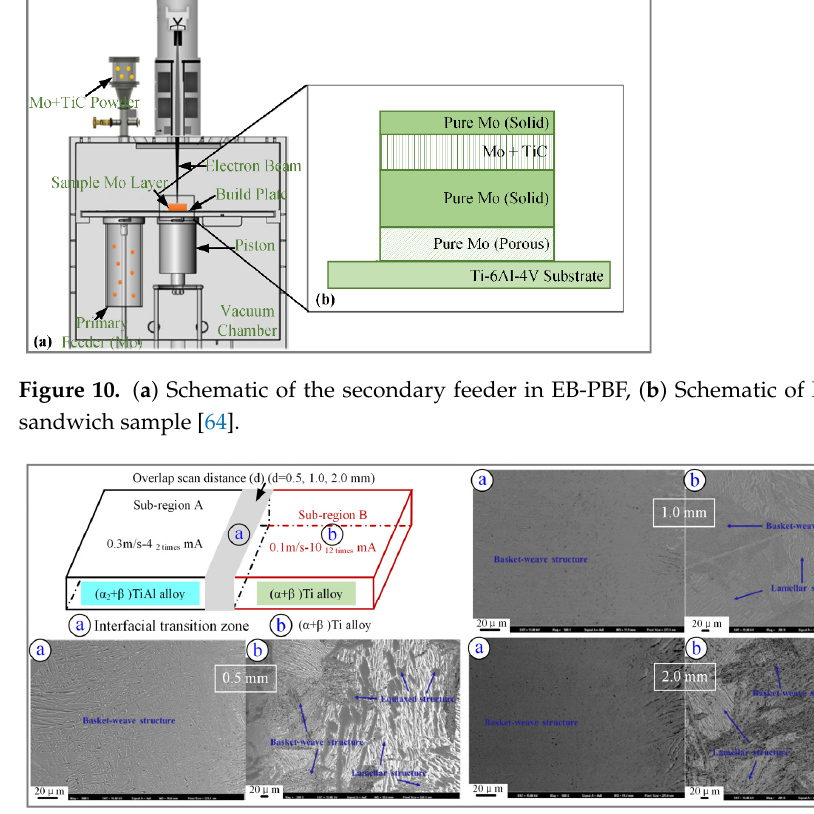
Figure 11. Schematic of the fabrication of FGMs by EBSM and the microstructure for different zones [36].